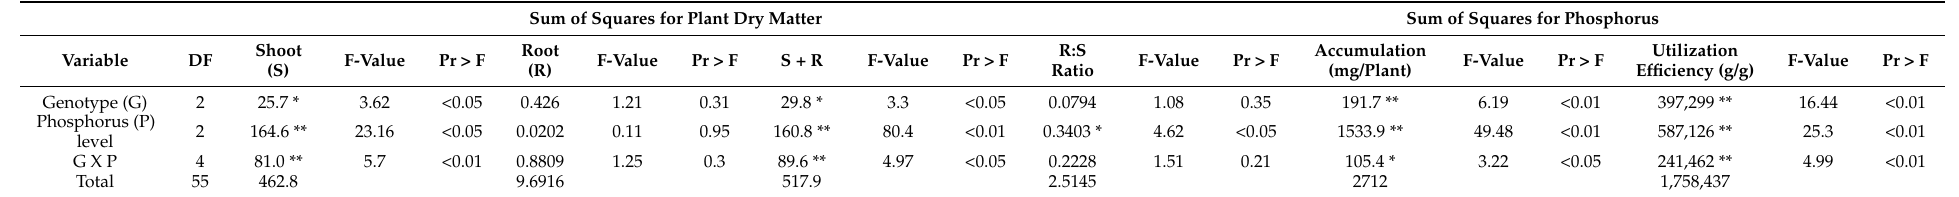
Table 1. Analysis of variance for three potato genotypes grown at three P levels including water soluble phosphate: 10 and 1 mg L − 1 P as sodium dihydrogen phosphate, NaH 2 PO 4 and water phosphate, 286 mg L − 1 TCP, tri-calcium phosphate, [Ca 3 (PO 4 ) 2 ] and 2286 mg L − 1 laboratory grade Ca 3 (PO 4 ) 2 in hydroponics for 28 days. Note: * significant at p < 0.05 and ** significant at p <